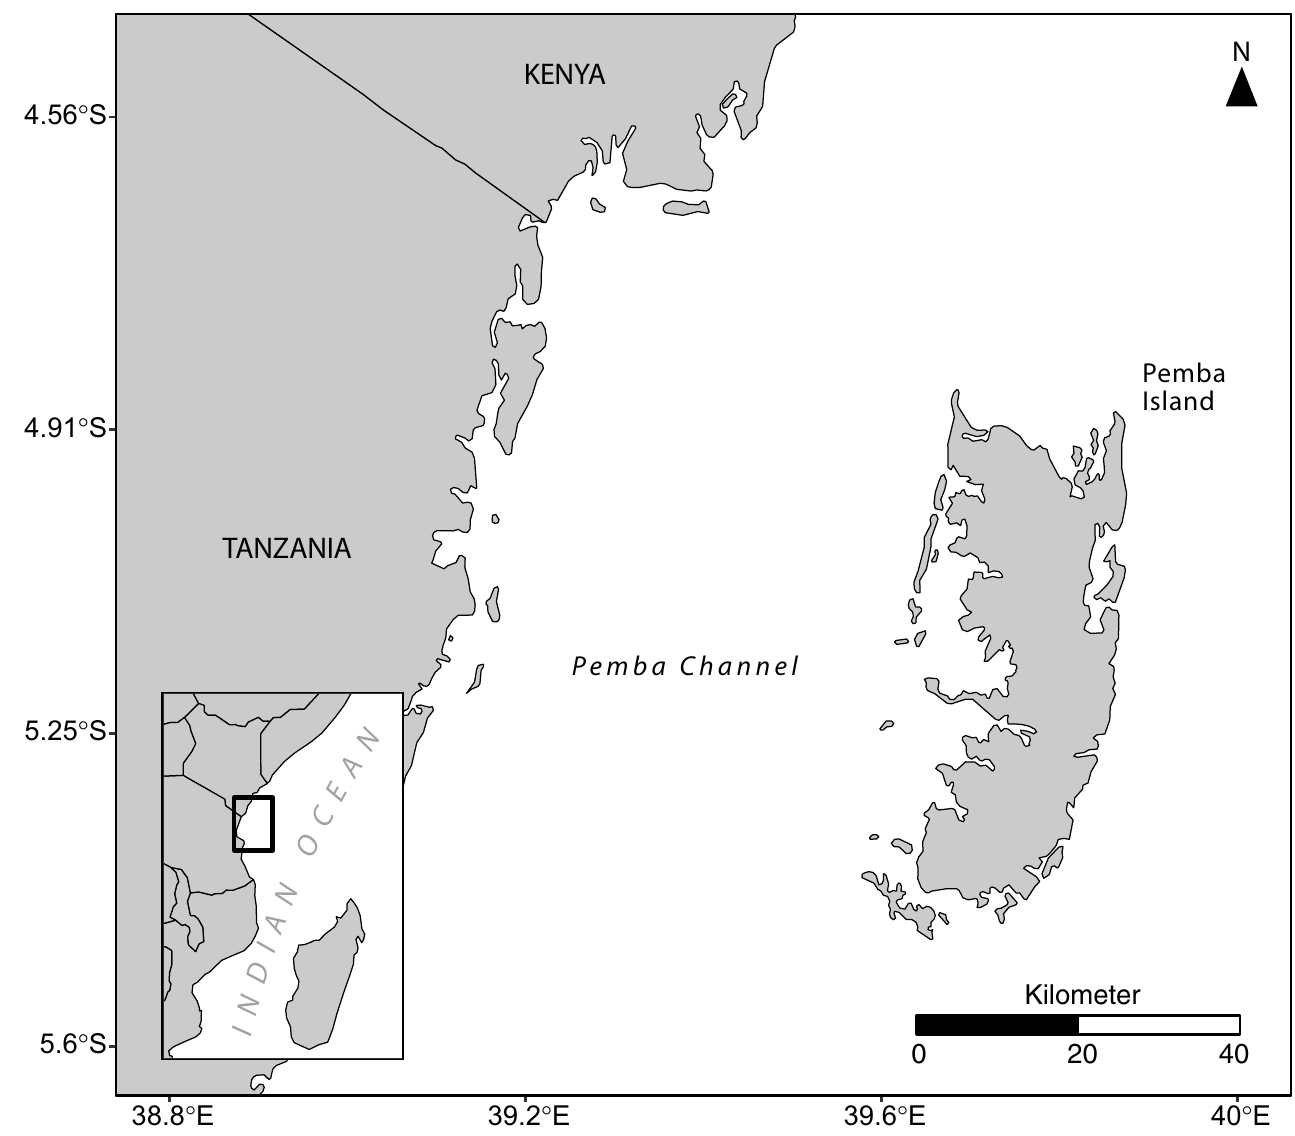
Fig 1. A map of the Pemba Channel. The inset map locates the Pemba channel (polygon with black color) in the Western Indian. The dataset used to draw these maps were obtained from the Institute of Marine sciences and spData package [30].